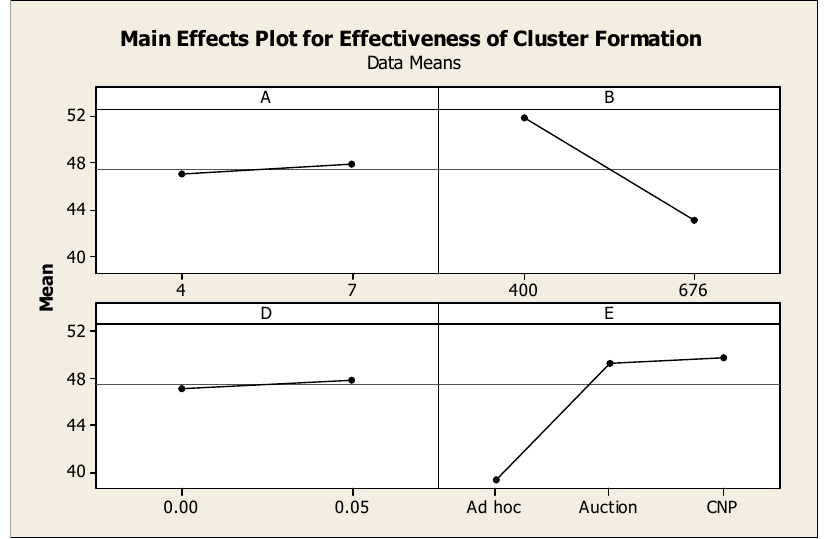
Figure 8. Main effect plot for effectiveness. n = 160, ANOVA, 1 df , p < 0.05.